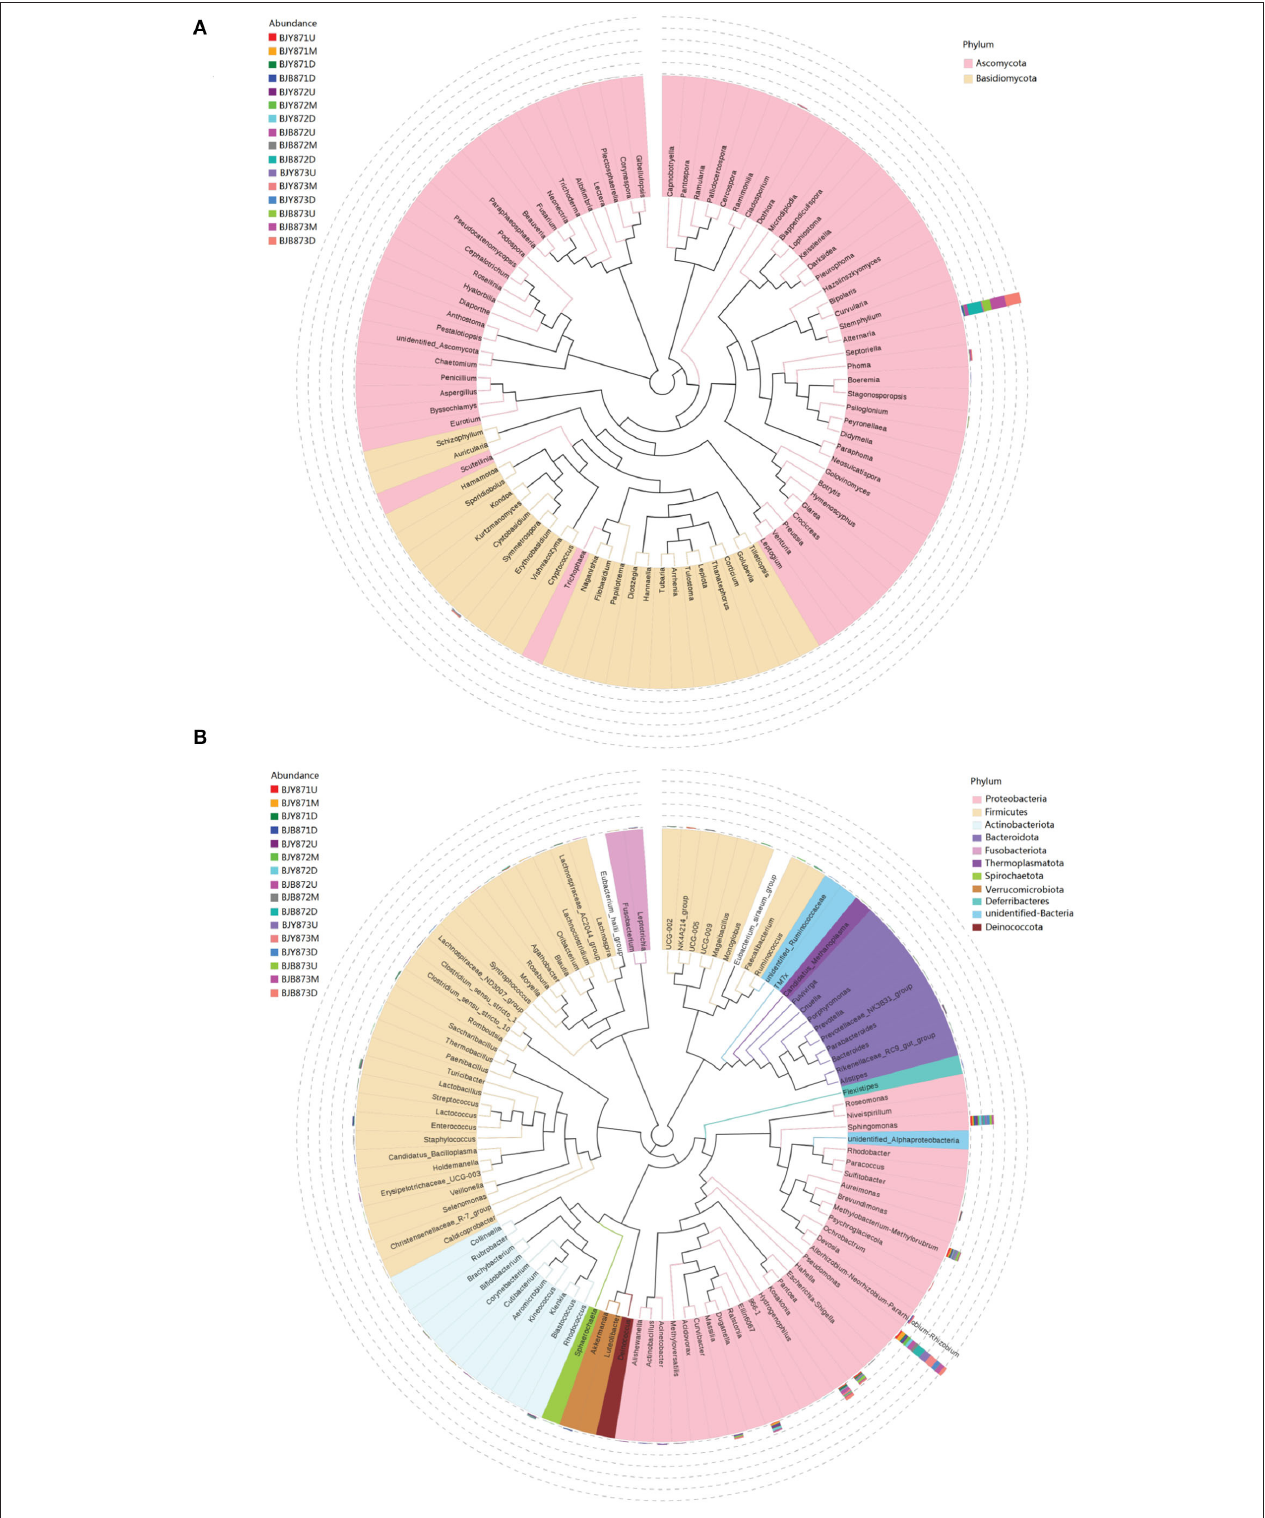
FIGURE 3 | Maximum likelihood (ML) tree of 100 most abundant fungal (A) and bacterial (B) genera from the tobacco leaves infected with Alternaria alternata obtained by the analysis of ITS rDNA and 16S rRNA pyrosequencing data.